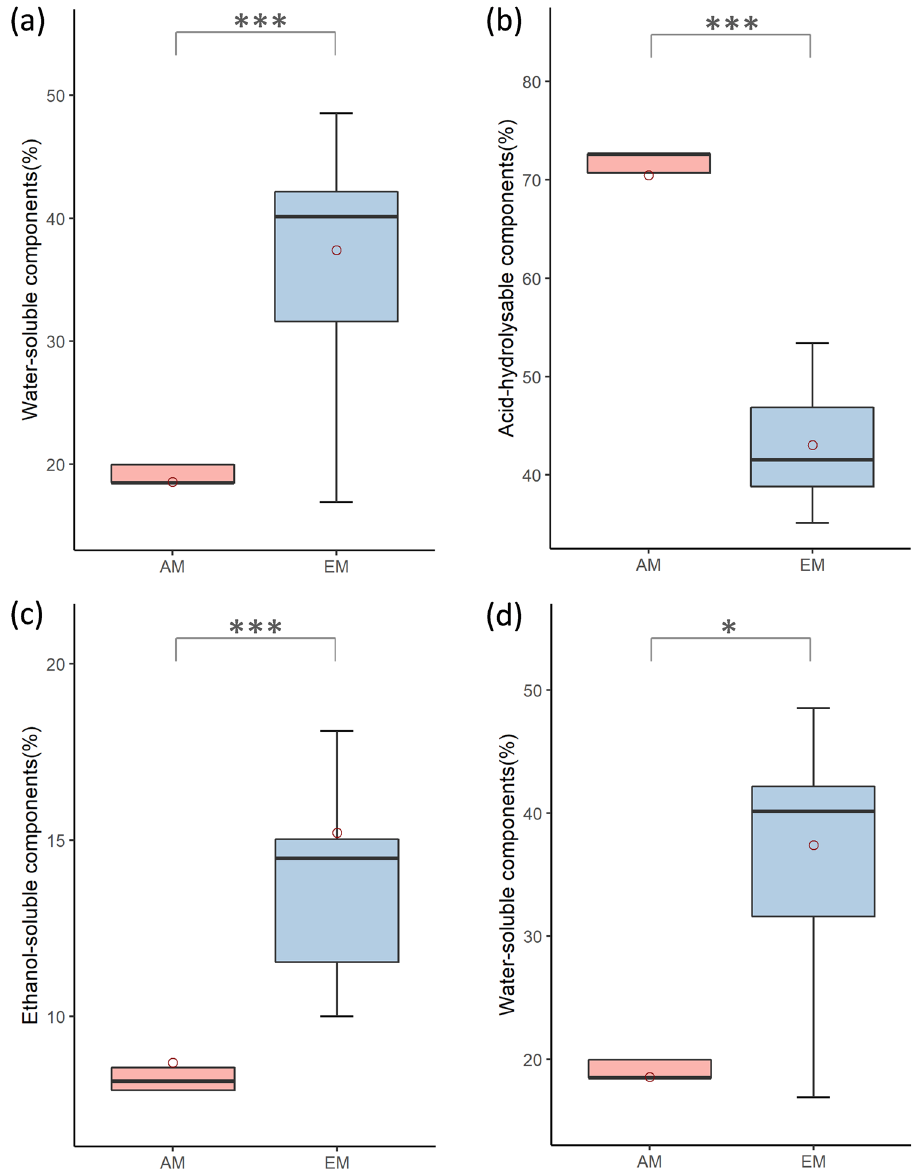
Fig. 3 Boxplots of WAEN components in AM and EM fungi. a Water-soluble components, P < 0.001, b Acid- hydrolysable components, P < 0.001, c Ethanol-soluble components, P < 0.001, d Non-extractable components, P < 0.05. All P values refer to the Mann – Whitney test, AM ( n = 4) and EM ( n = 11). Upper and lower limits of the box- quartiles around the weighted-mean, horizontal lines within boxes- weighted-median values within each mycorrhiza group, and red circles - weighted-mean of each mycorrhiza group.